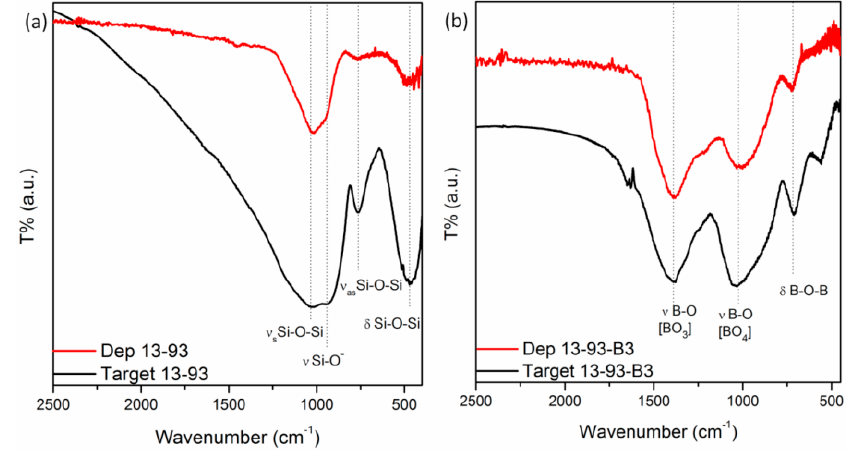
Figure 1. FT-IR spectra of target materials (black lines) and deposited films (red lines) of ( a ) 13-93 and ( b ) 13-93-B3 BGs.